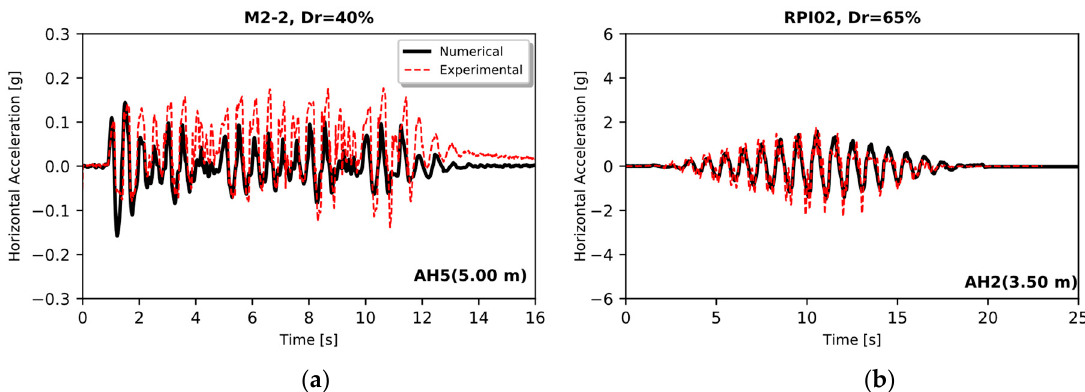
Figure 12. Numerical versus experimental horizontal accelerations in ( a ) M2-2 and ( b ) RPI-02